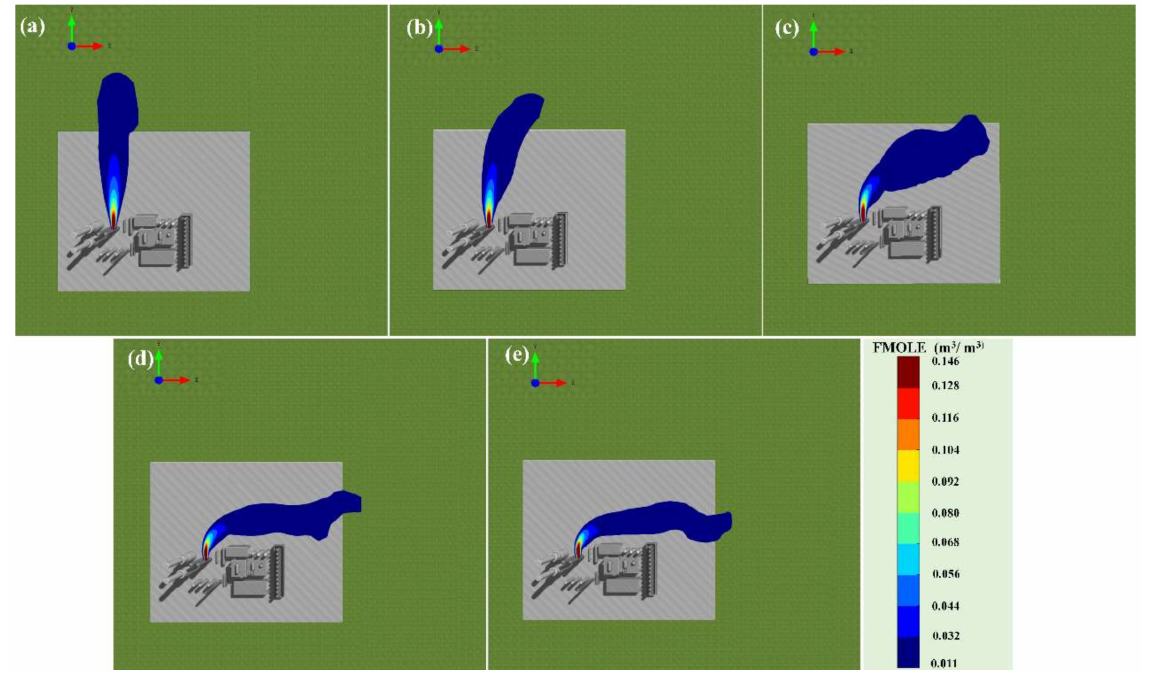
Figure 6. Cloud map of combustible gas volume fraction under different wind speeds. ( a ) Cloud map affected by 0.2 m · s − 1 wind speed. ( b ) Cloud map affected by 1 m · s − 1 wind speed. ( c ) Cloud map affected by 3 m · s − 1 wind speed. ( d ) Cloud map affected by 5 m · s − 1 wind speed. ( e ) Cloud map affected by 6 m · s − 1 wind